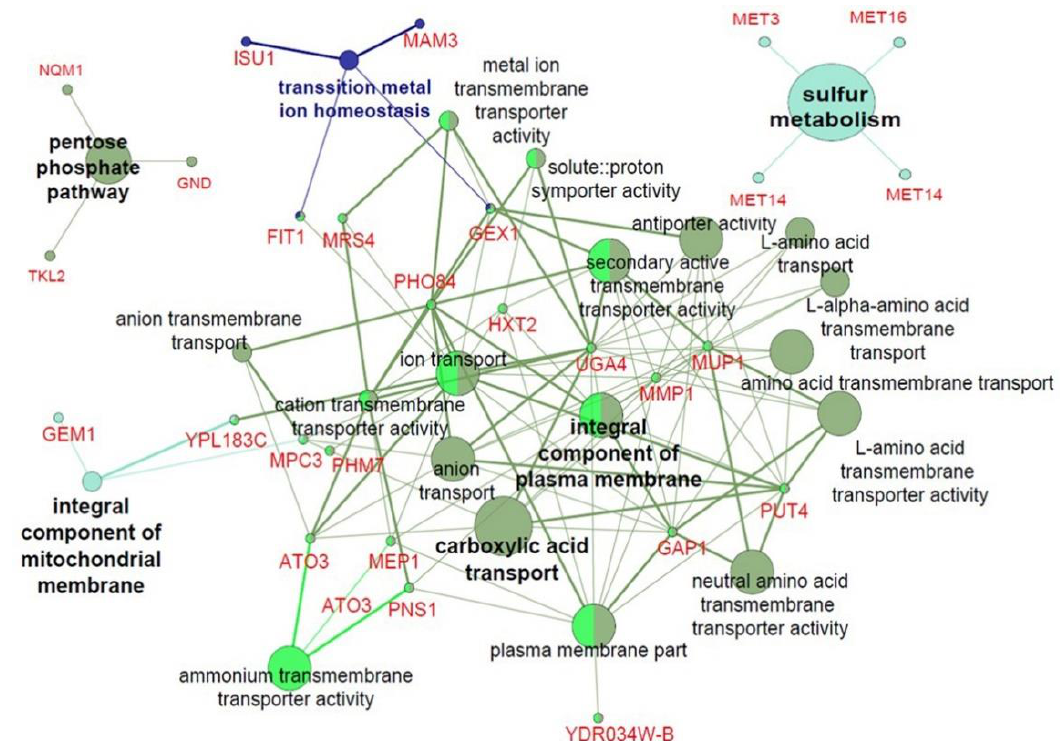
Figure 3. ClueGO-based genetic network analysis of upregulated genes associated with the pentose phosphate pathway, sulfur metabolism, and integral component of mitochondrial component and plasma membrane in DaMDHAR -expressing yeast cells under repeated FT (FT2) stress.